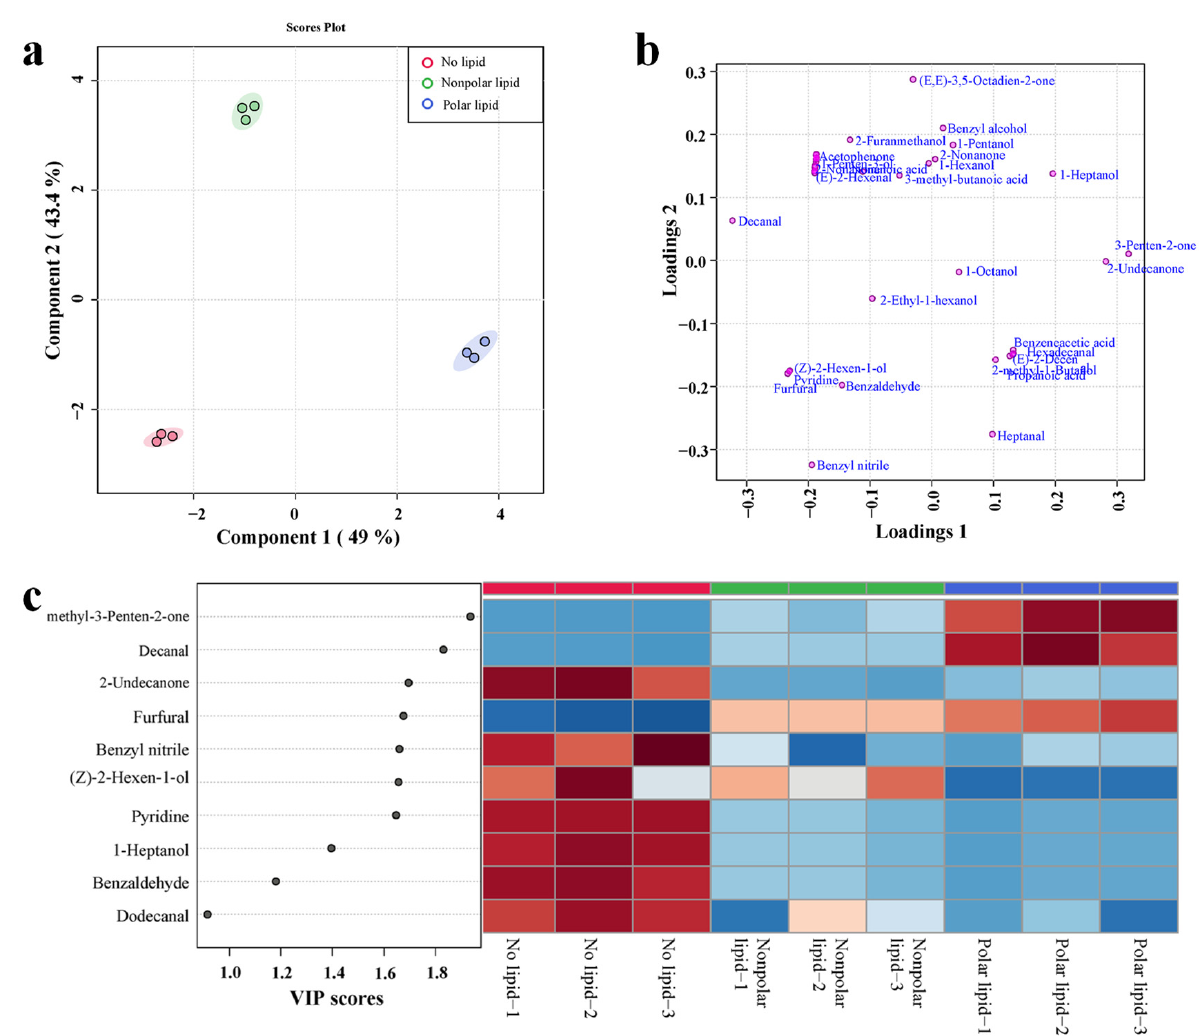
Figure 3. PLS-DA analysis diagram of volatile compounds in MRPs with different polarity lipids: ( a ) scores plot; ( b ) loading plot; ( c ) VIP plot and heatmap.